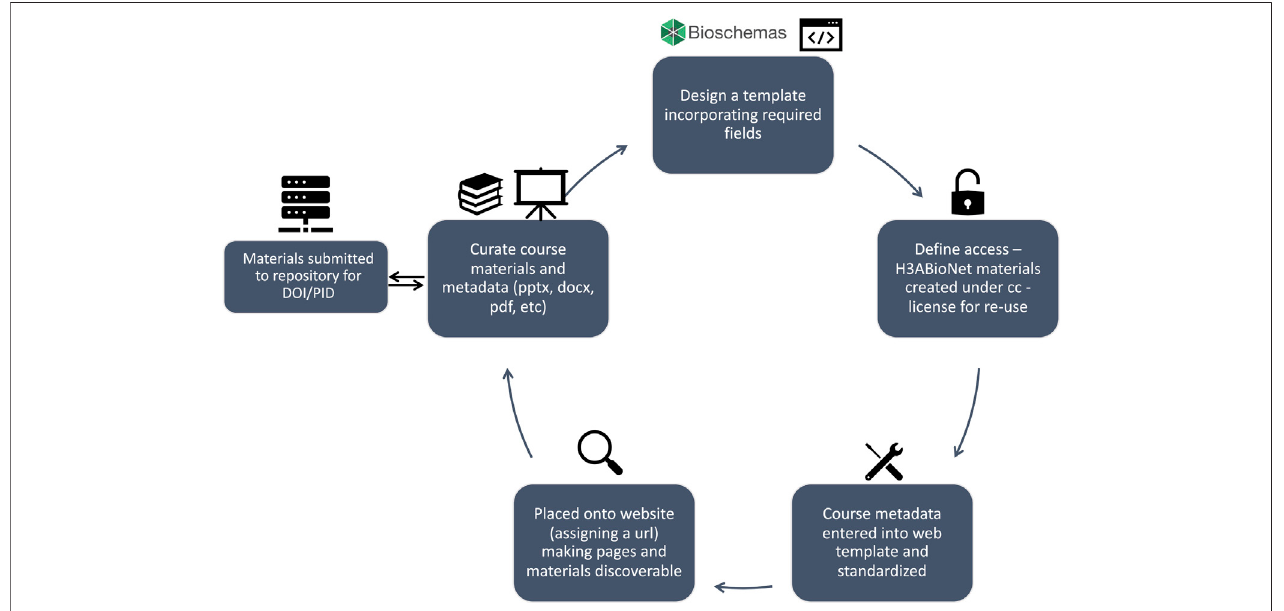
FIGURE 1 | Graphical depiction of the process being used by H3ABioNet to make training materials